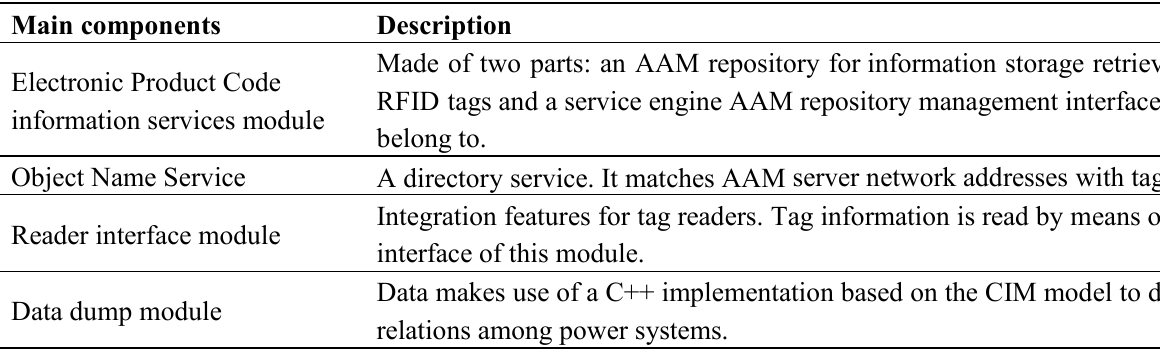
Table 1. Description of GridStat main